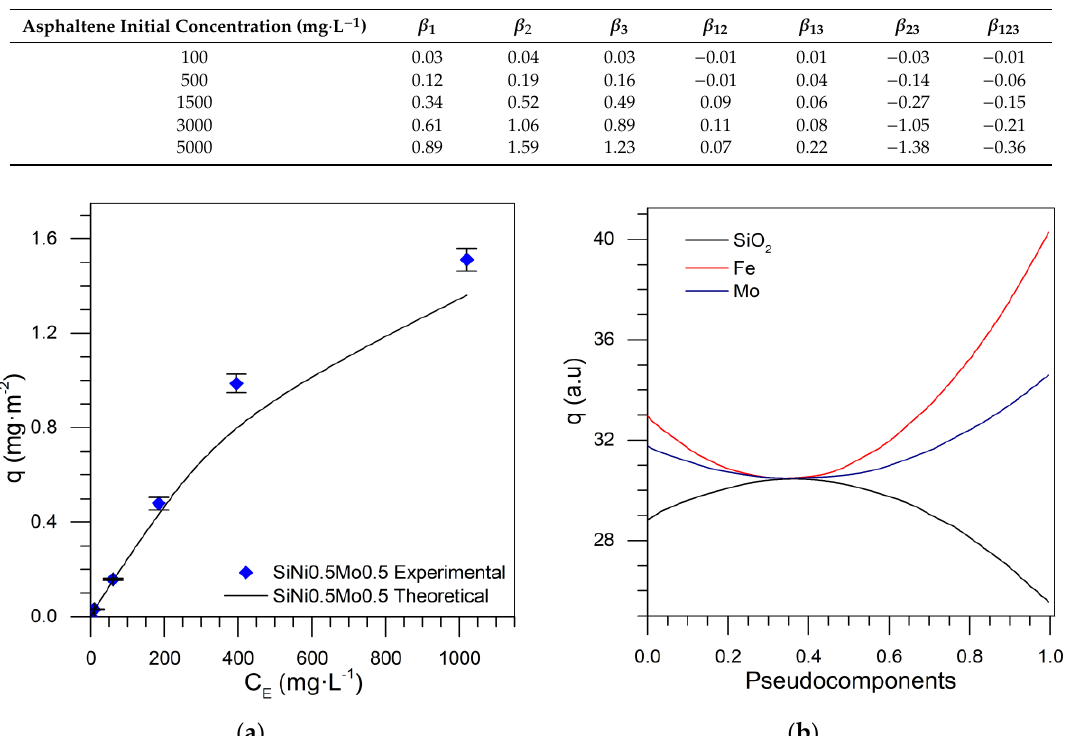
Figure 10. Response surface of adsorption for the mixture design of Si-Fe-Mo at 100 mg·L −1.